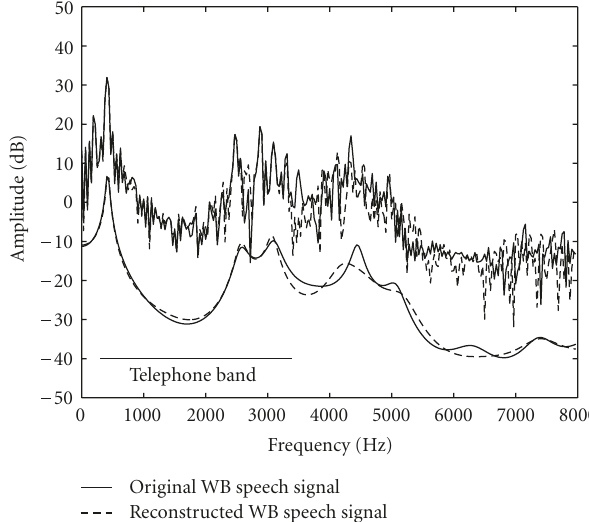
Figure 8: Spectra and spectral envelopes (with a − 25 dB o ff set for display purposes) of original WB speech signal (solid line) and re- constructed WB speech signal (dashed line) produced by SBE de- coder.